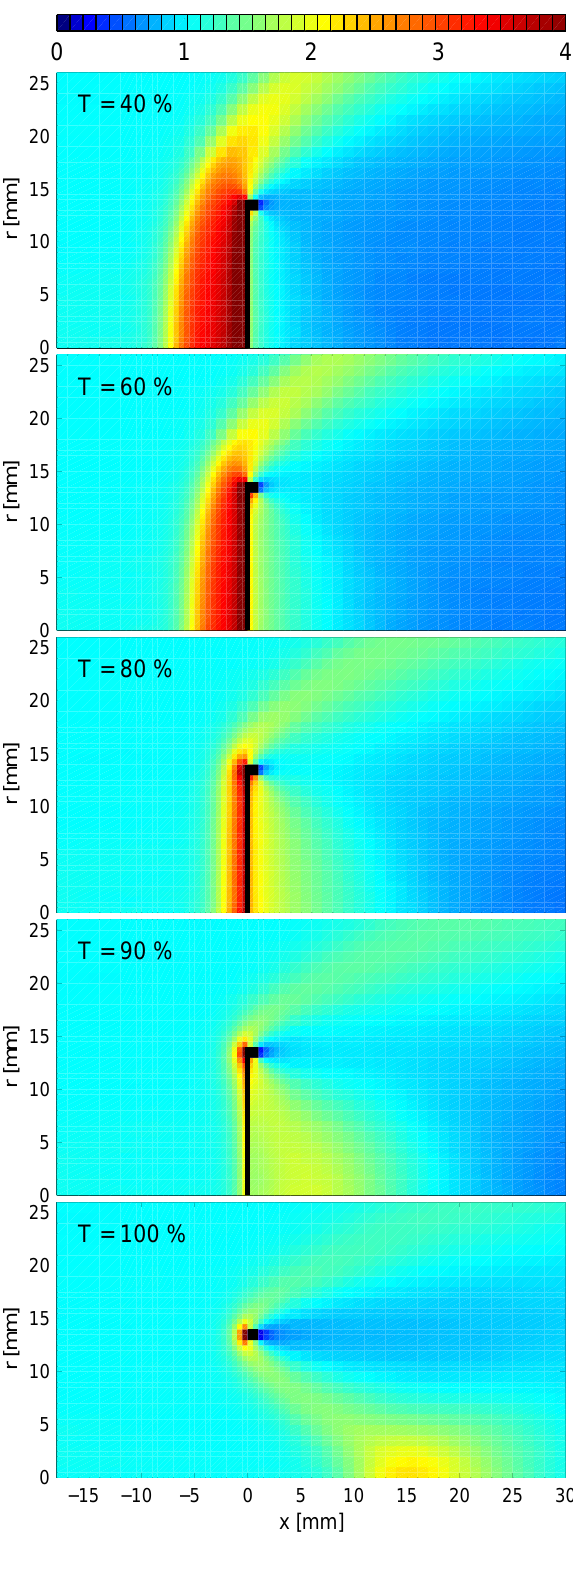
Fig. 5. As Fig. 4, but for a molecular mean free path λ ∞ = 10